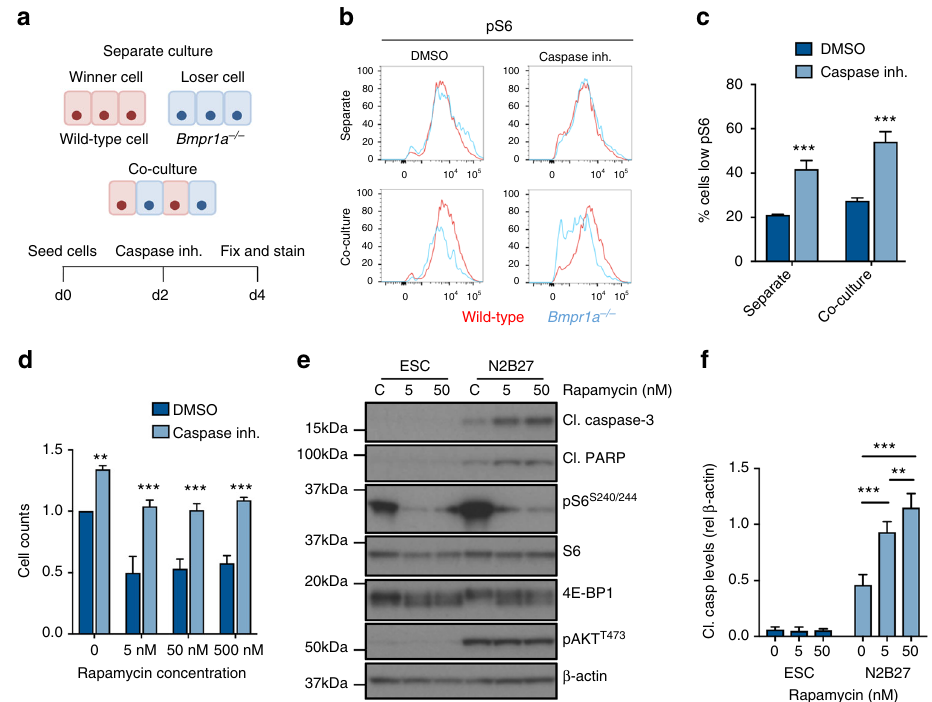
Fig. 2 Repression of the mTOR pathway triggers cell death in differentiating ESCs. a Schematic of experimental setup whereby cells were cultured separately and together for two days in N2B27 before being treated with 100 μ M caspase inhibitors for 48 h. Cells were then fi xed and levels of pS6 S240/244 were assessed. b Levels of pS6 S240/244 were assessed by fl ow cytometry in wild-type and Bmpr1a − / − cells following 48 h treatment with DMSO or caspase inhibitors (100 uM), and c median fl uorescence of Bmpr1a − / − cells was quanti fi ed. d Wild-type cells were cultured in N2B27 for 2 days, treated with mTOR inhibitor rapamycin for 24 h and cell count was assessed following treatment with and without caspase inhibitors. e Wild-type cells cultured in ESC media, to maintain pluripotency, and N2B27, to initiate differentiation, were treated with rapamycin for 6 h and levels of cell death were assessed by western blot analysis of cl. caspase-3 and cl. PARP. f Quanti fi cation of cleaved caspase-3 levels relative to β -actin. Error bars denote